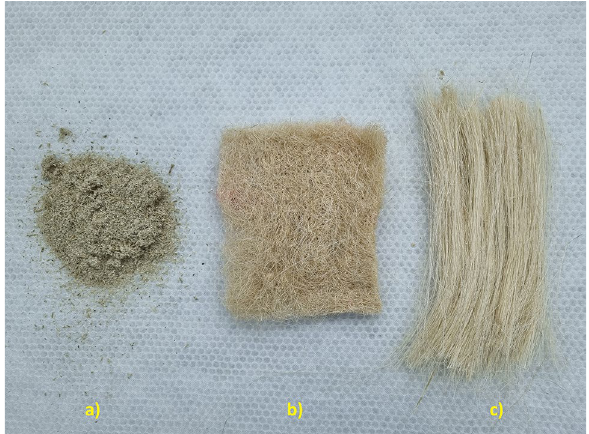
Figure 1. Raw fique: ( a ) powder (FP), ( b ) non-woven mat (NWF), ( c ) unidirectional mat